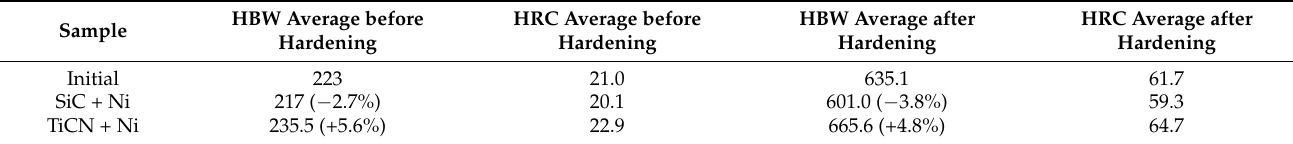
Table 5. The W6Mo5Cr4V2 steel